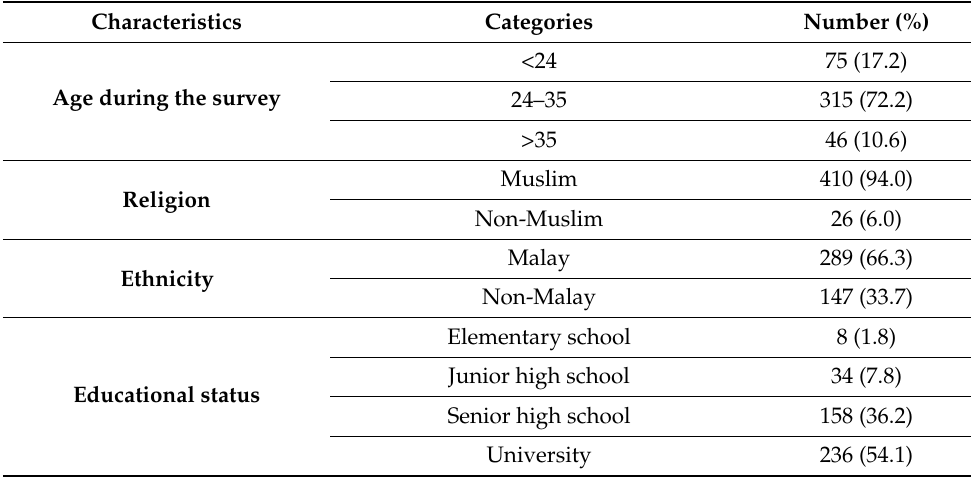
Table 1. Sociodemographic characteristics of women aged 15–49 years, Municipality of